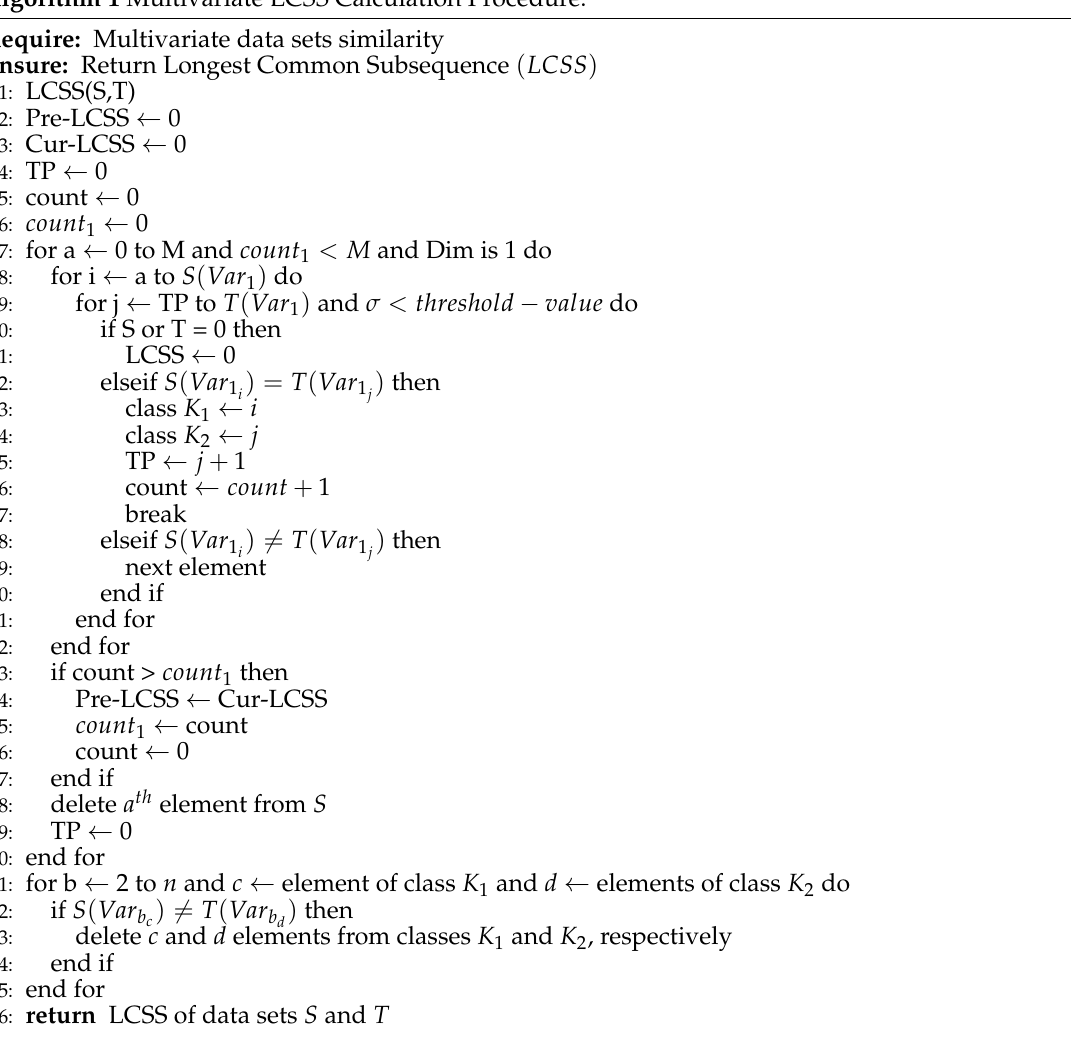
Algorithm 1 Multivariate LCSS Calculation